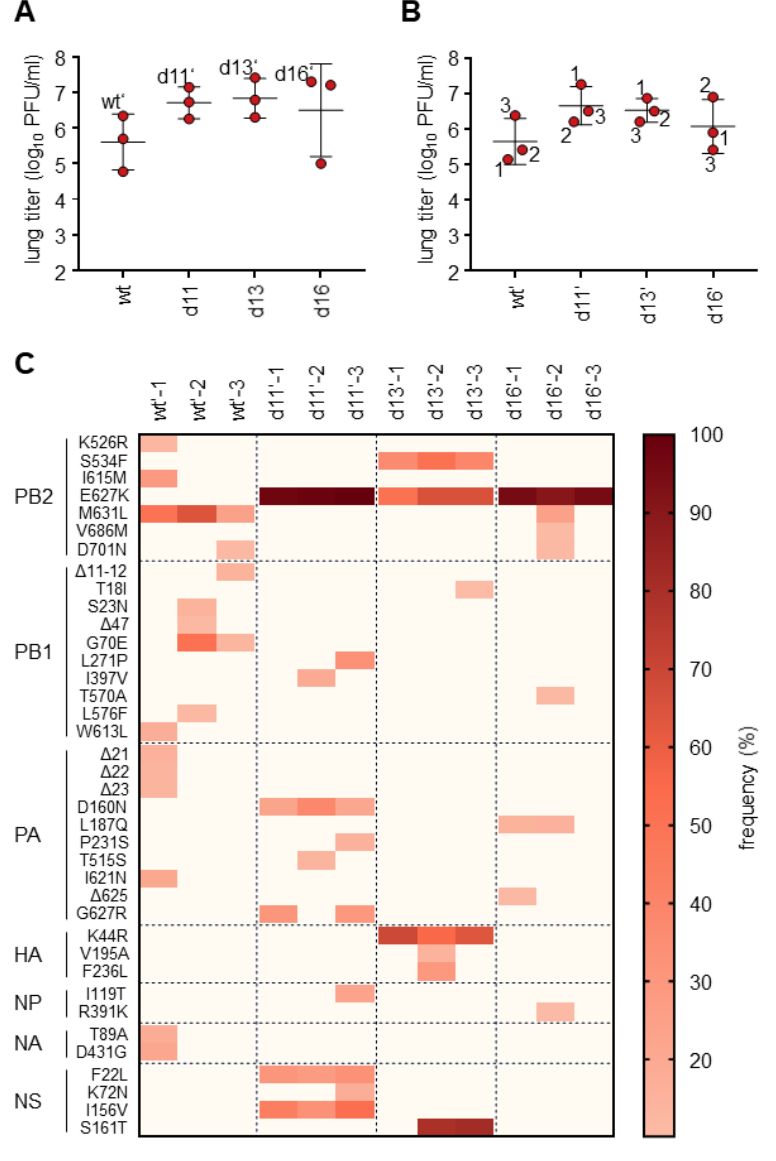
Figure 3. Virus isolates from MxA tg/- Rag2 -/- mice show enhanced replication in MxA tg/tg mice. ( A ) MxA tg/tg mice were infected intranasally with 10 4 PFU of the viral lung isolates of day 11, day 13, and day 16 in Figure 2 or wt H7N9 as a control. The lungs of the infected mice were harvested 3 dpi to determine viral titers. ( B ) MxA tg/tg mice were infected intranasally with 10 4 PFU of the viral iso- lates with the highest titers in each group from the experiment shown in ( A ) (indicated with ‘). The lungs of the infected mice were harvested 3 dpi to determine viral titers via plaque assay. ( C ) The twelve isolates from ( B ) were subjected to full-genome sequencing for frequency analysis of adap- tive mutations. All mutations that were found with a frequency of at least 10% are listed. HA muta- tions are displayed according to H7N7 numbering [23].